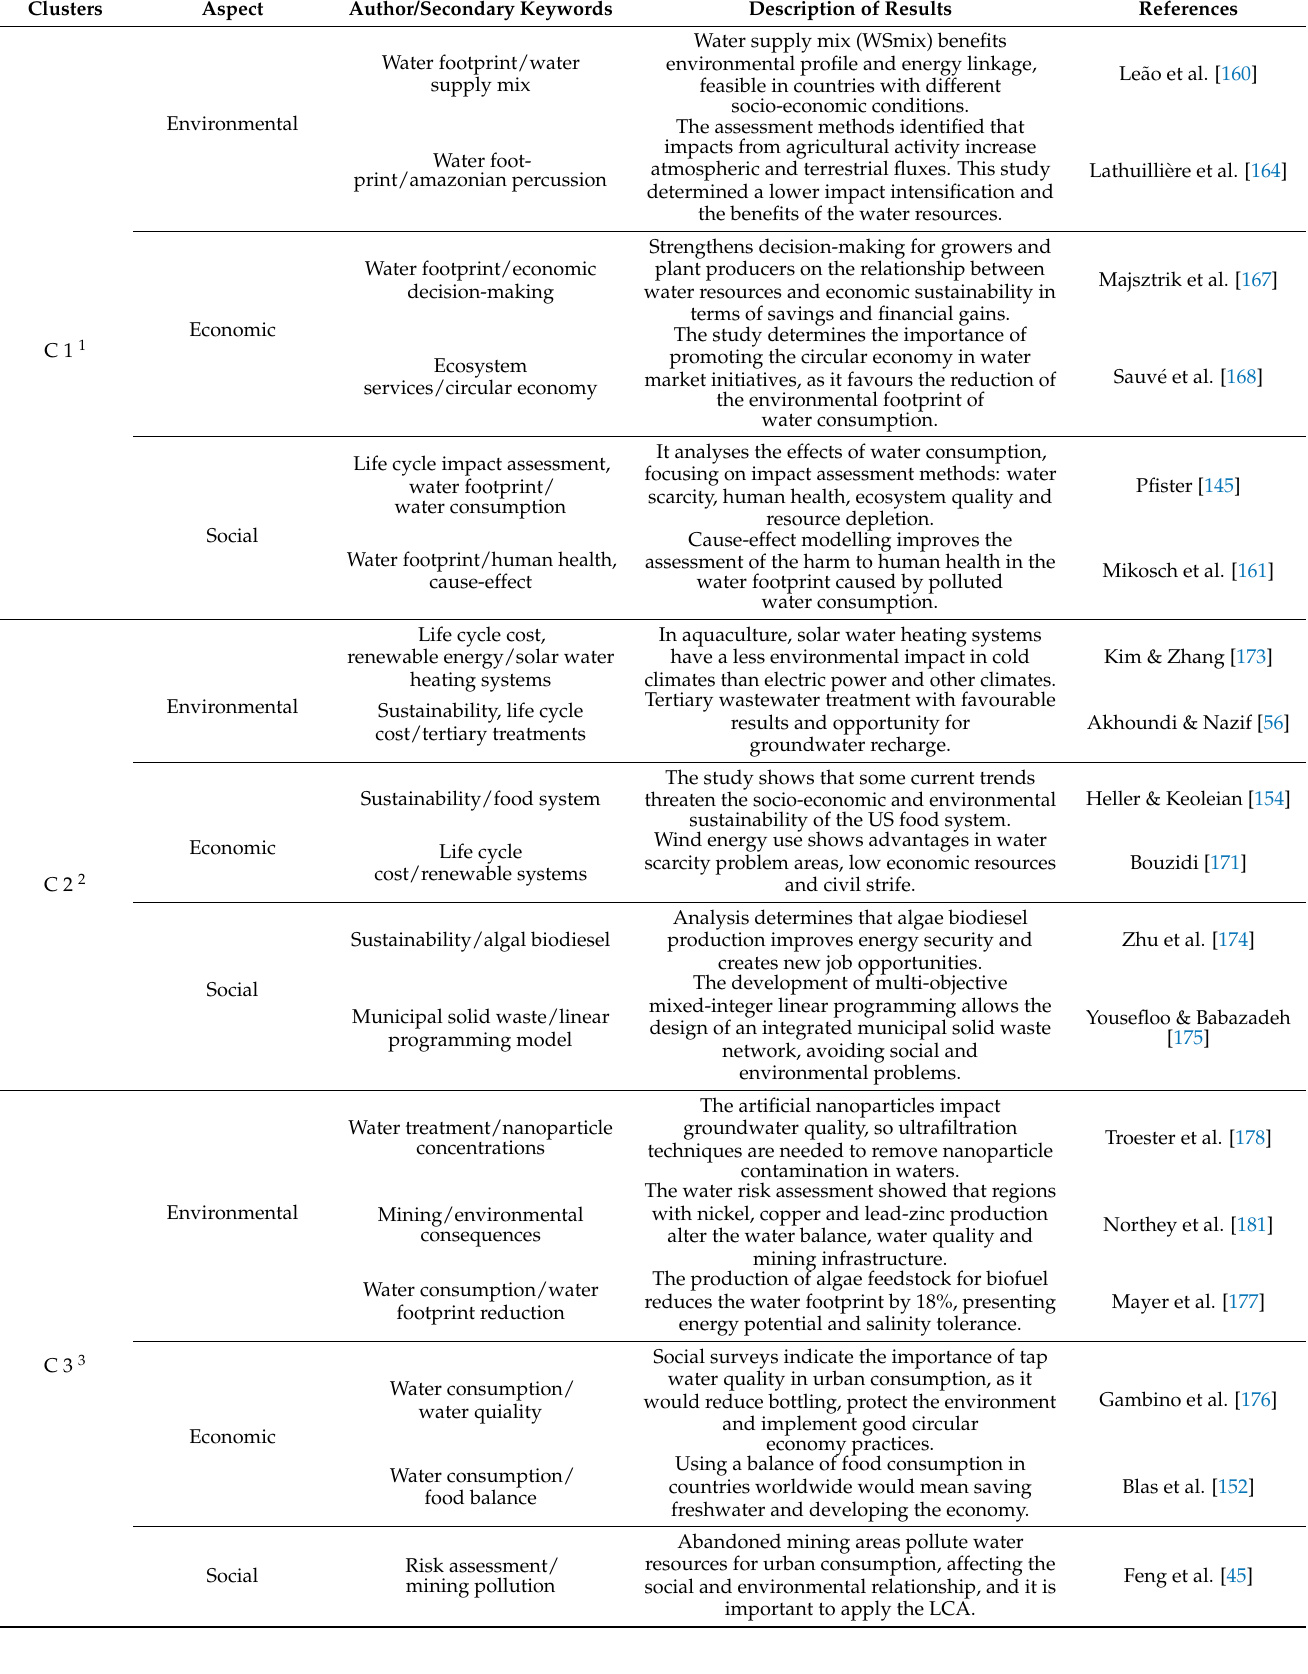
Table 2. Literature review of Author Keywords in an environmental, economic and social